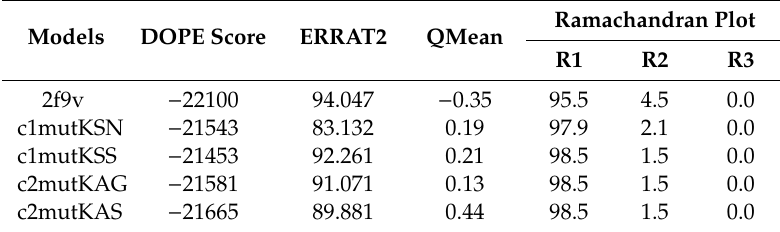
Figure 1. ( a ) Multiple hepatitis C virus (HCV) NS3 sequence alignment between the four hepatitis C virus genotype 1a (HCV-1a) clade protein sequences and the Protein Data Bank (PDB) 2f9v template; positions 80 (pink), 174 (green), 91 (green), and the catalytic residues 57, 81, and 139 (blue) are highlighted. ( b ) Multiple HCV NS4A cofactor sequence alignment between the four HCV-1a clade protein sequences and the PDB 2f9v template. Table 1. Evaluation of HCV NS3 protein